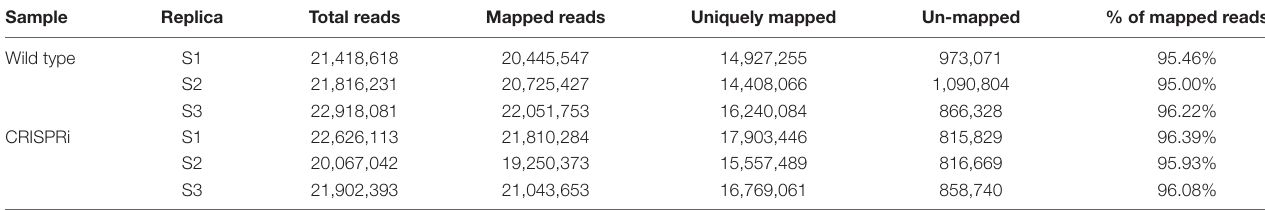
TABLE 4 | Reads mapped to genome for the analysis of differentially expressed genes. Sample Mapped reads Uniquely mapped